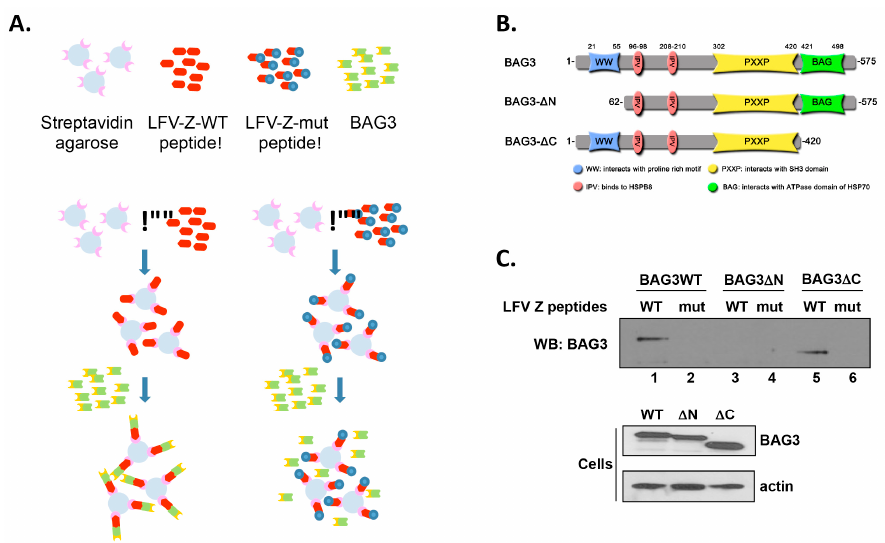
Figure 2. Analysis of viral PPxY-host WW-domain interactions between BAG3 and LFV-Z by peptide pull-down assays. ( A ) Flow chart of the peptide pull-down assay using LFV-Z peptides and cell lysates expressing BAG3-WT; ( B ) Schematic diagram of BAG3-WT, BAG3- Δ N, and BAG3- Δ C mutants with the various domains highlighted in color and amino acid positions indicated; ( C ) Western blot of peptide pull-down assay using streptavidin agarose beads conjugated with either the LFV-Z WT or LFV-Z PY mutant peptide. BAG3 proteins were detected using anti-c-myc antibody (top blot). Expression controls for BAG3 and actin are shown in the bottom blot. These results are from 1 of 2 independent experiments.